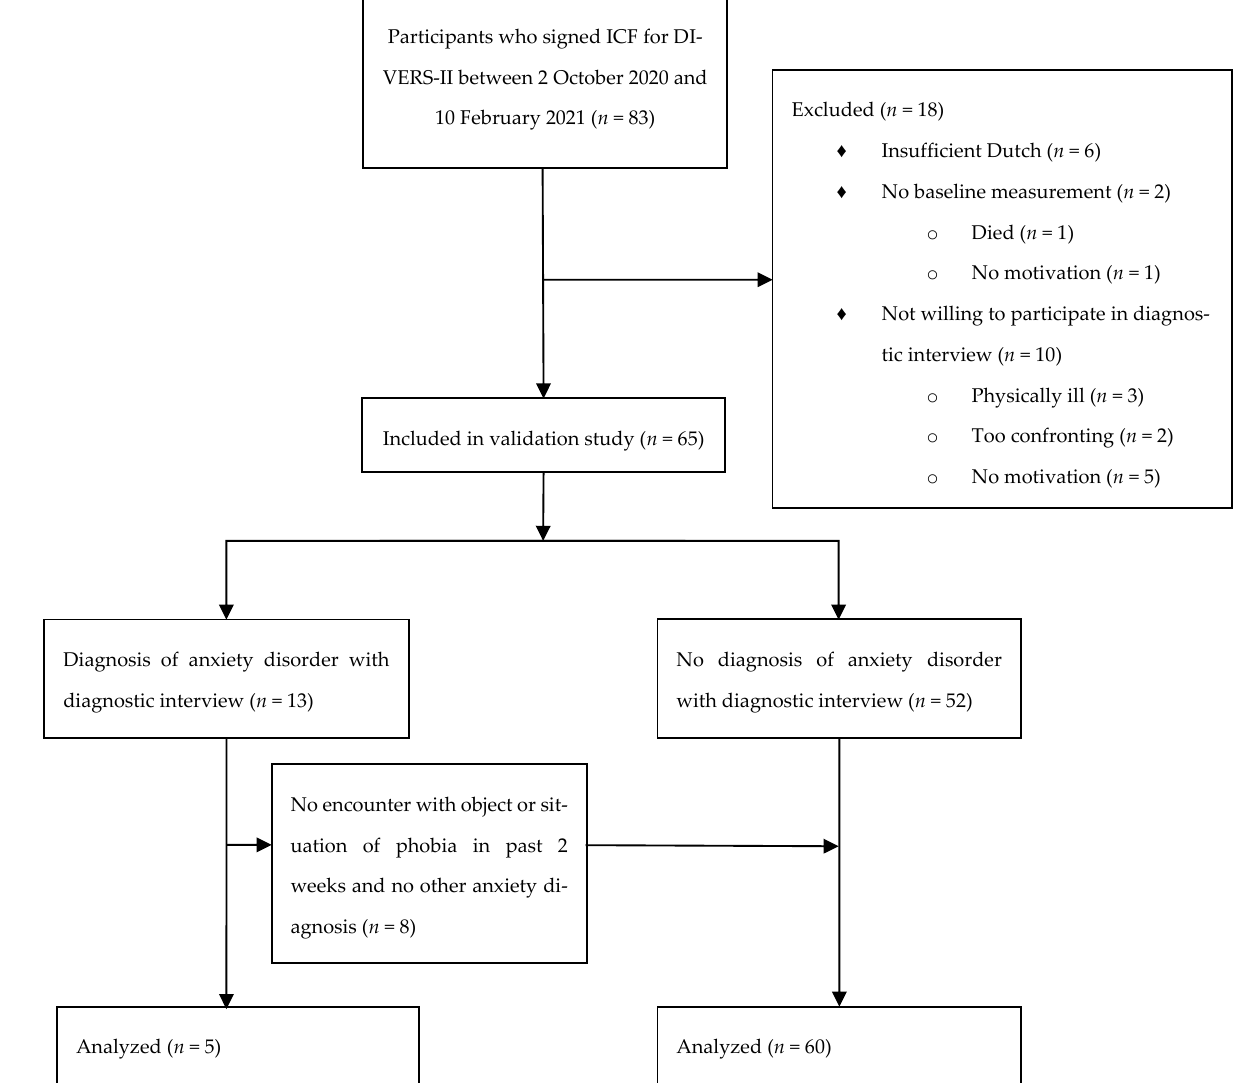
Figure 1. Patient flow diagram. Abbreviations: ICF, informed consent form; DIVERS-II, Depression Related Factors and Outcomes in Dialysis Patients With Various Ethnicities and Races Study—Internet